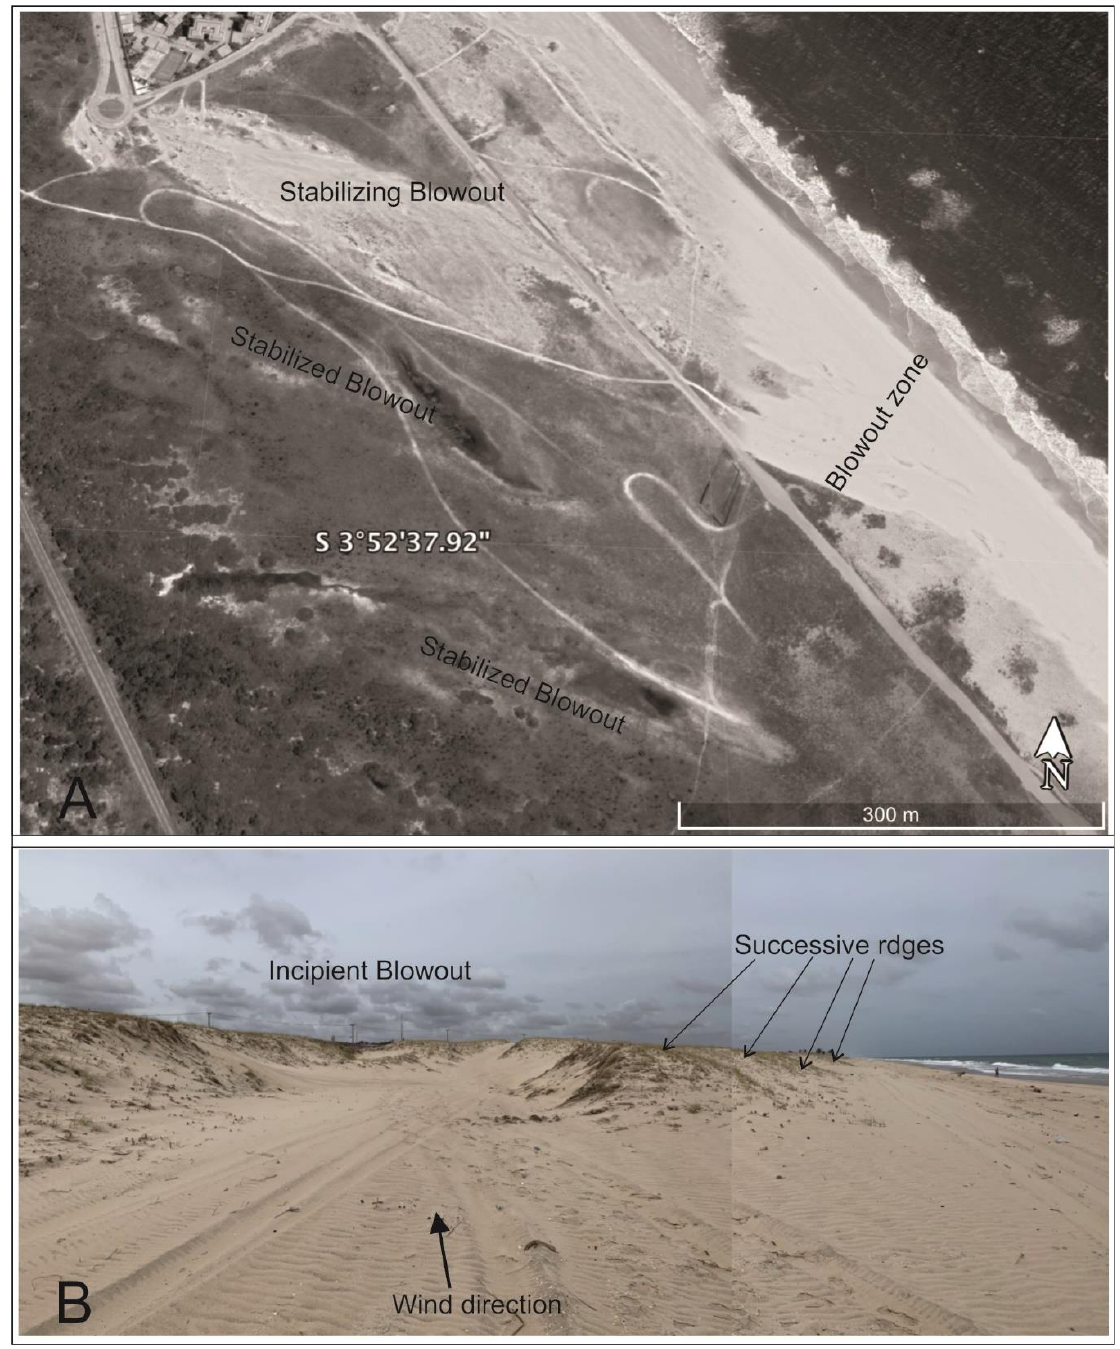
Figure 8. ( A ) Satellite image showing three stages of the blowout evolution; a current blowout zone; a stretch with a blowout in a stabilization stage; blowouts already stabilized, showing remnants of parabolic hairpin dunes downstream. ( B ) Development of blowout on incipient foredune. Porto das Dunas beach.